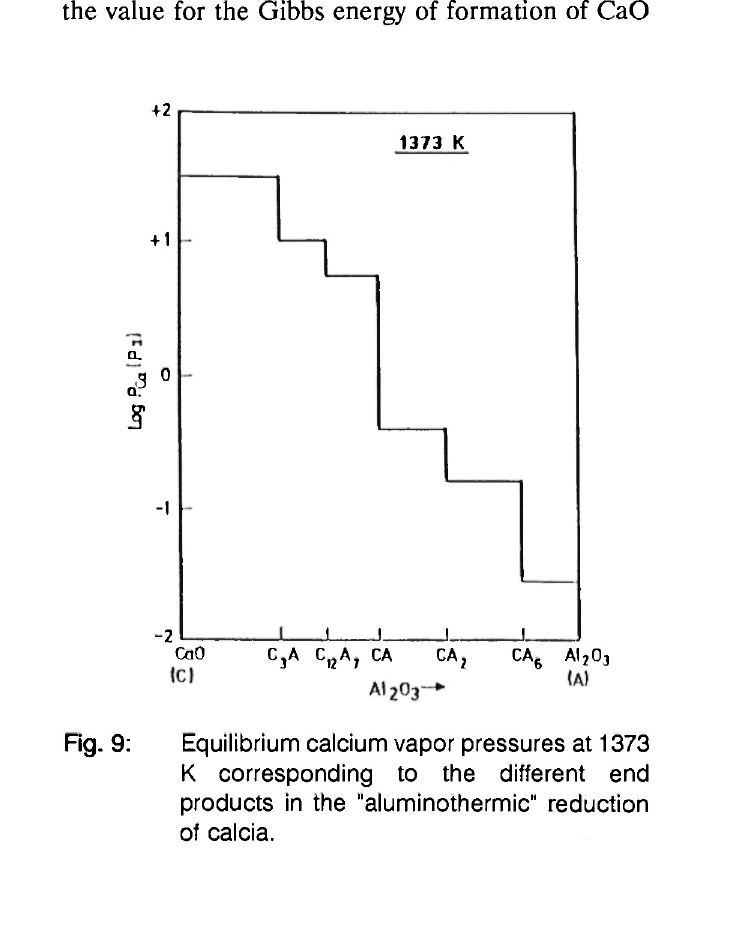
Fig. 8: Experimental calcium vapor pressures corresponding to the reaction 6CaO(s) + 2AI(1) - 3Ca0-AI 2 0 3 (s) + 3Ca(g).